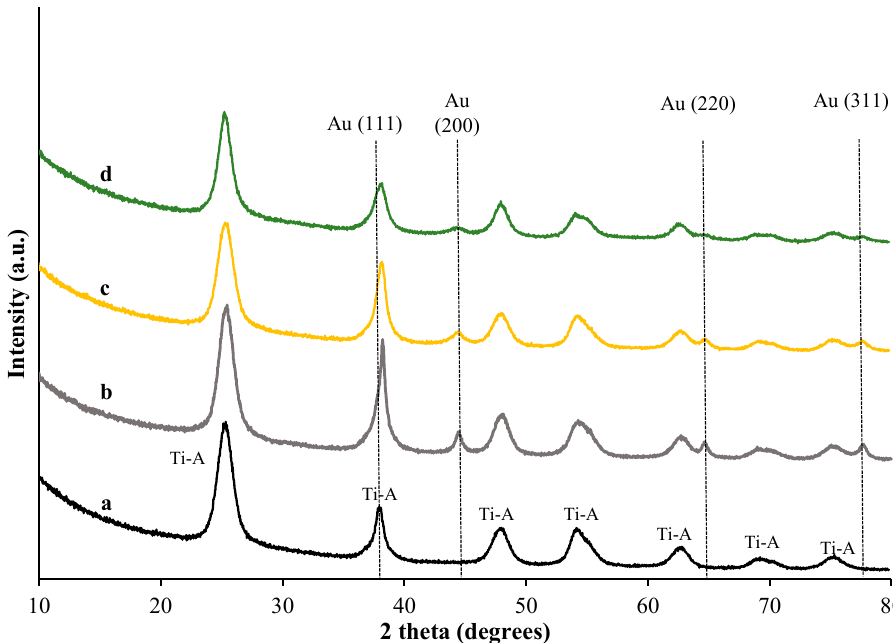
Figure 3. XRD patterns of titania materials prepared by microwave heating: ( a ) bare TiO 2 , ( b ) TiO 2 @Au prepared with ethanol, ( c ) TiO 2 @Au-RB, and ( d ) TiO 2 @Au-HP. Table 1. Surface properties and gold loading of the di ff erent TiO 2